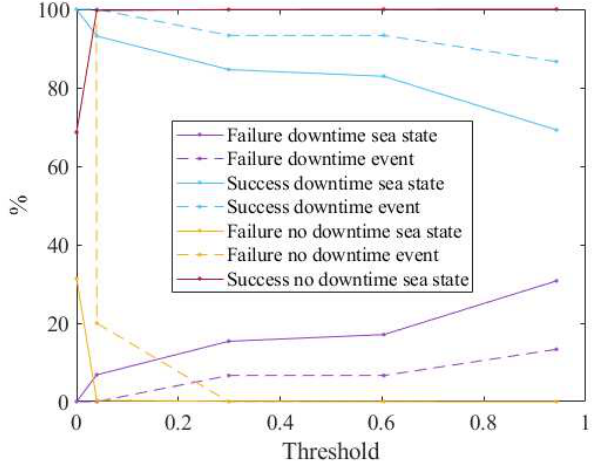
Figure 9. Relationship between different thresholds and model performance: successes and failures for sea states and events.